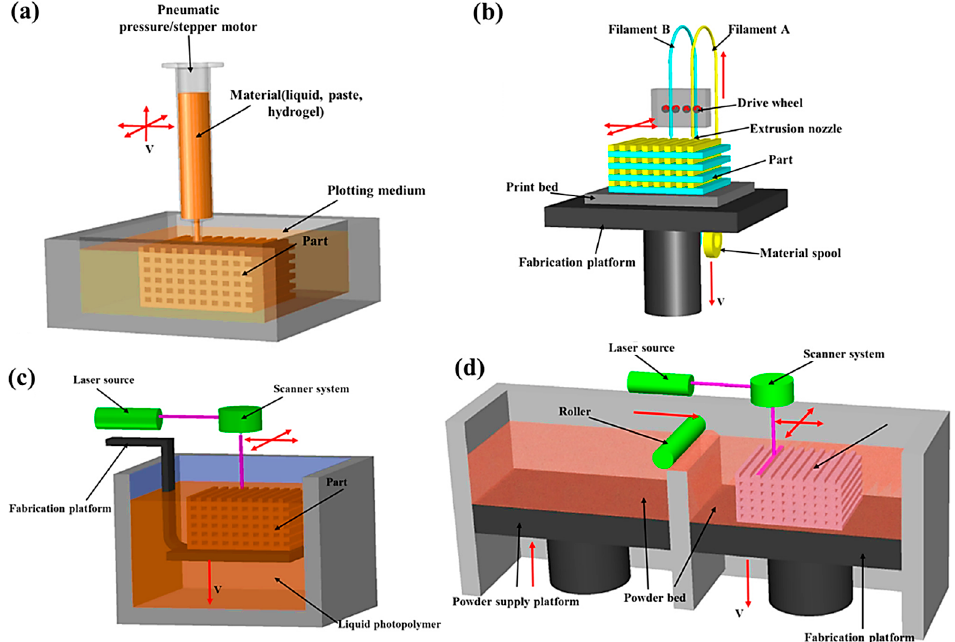
Figure 6. Schematic of ( a ) direct ink printing set-up; ( b ) FDM setup; ( c ) SLA setup; and ( d ) SLS setup [87]. FDM = fused deposition modeling; SLA = stereolithography; SLS = selective laser sintering. Reproduced with permission from Elsevier.